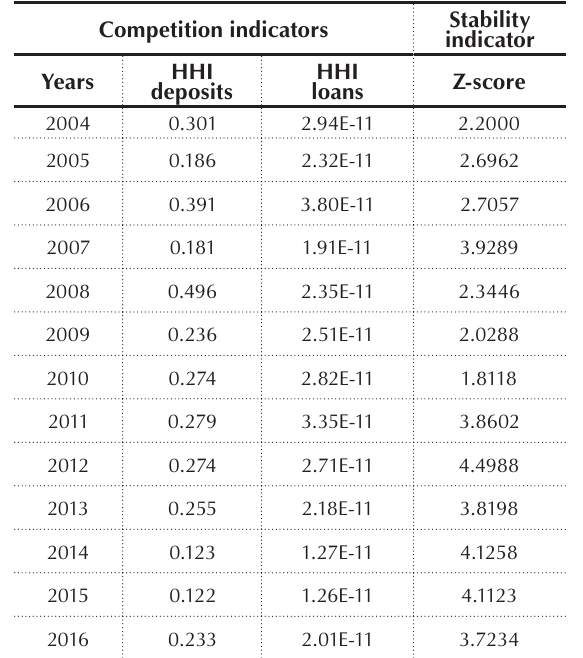
Table 1. (cid:18)(cid:381)(cid:373)(cid:393)(cid:286)(cid:415)(cid:415)(cid:381)(cid:374)(cid:3)(cid:258)(cid:374)(cid:282)(cid:3)(cid:400)(cid:410)(cid:258)(cid:271)(cid:349)(cid:367)(cid:349)(cid:410)(cid:455)(cid:3)(cid:373)(cid:286)(cid:258)(cid:400)(cid:437)(cid:396)(cid:286)(cid:400)(cid:3)(cid:296)(cid:381)(cid:396)(cid:3) (cid:410)(cid:346)(cid:286)(cid:3)(cid:104)(cid:60)(cid:3)(cid:271)(cid:258)(cid:374)(cid:364)(cid:400)(cid:3)(cid:894)(cid:410)(cid:381)(cid:410)(cid:258)(cid:367)(cid:3)(cid:374)(cid:437)(cid:373)(cid:271)(cid:286)(cid:396)(cid:3)(cid:381)(cid:296)(cid:3)(cid:271)(cid:258)(cid:374)(cid:364)(cid:400)(cid:3)(cid:296)(cid:396)(cid:381)(cid:373)(cid:3)(cid:410)(cid:346)(cid:286)(cid:3)